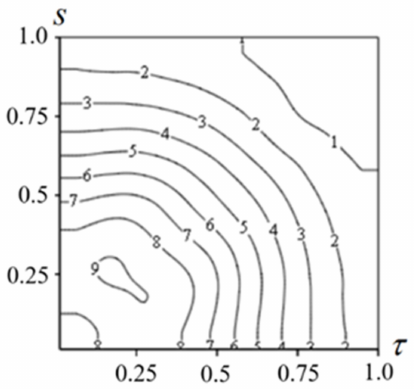
Figure 6. Estimation of the kernel ˆ K 2 ( τ , s ) , built on noisy